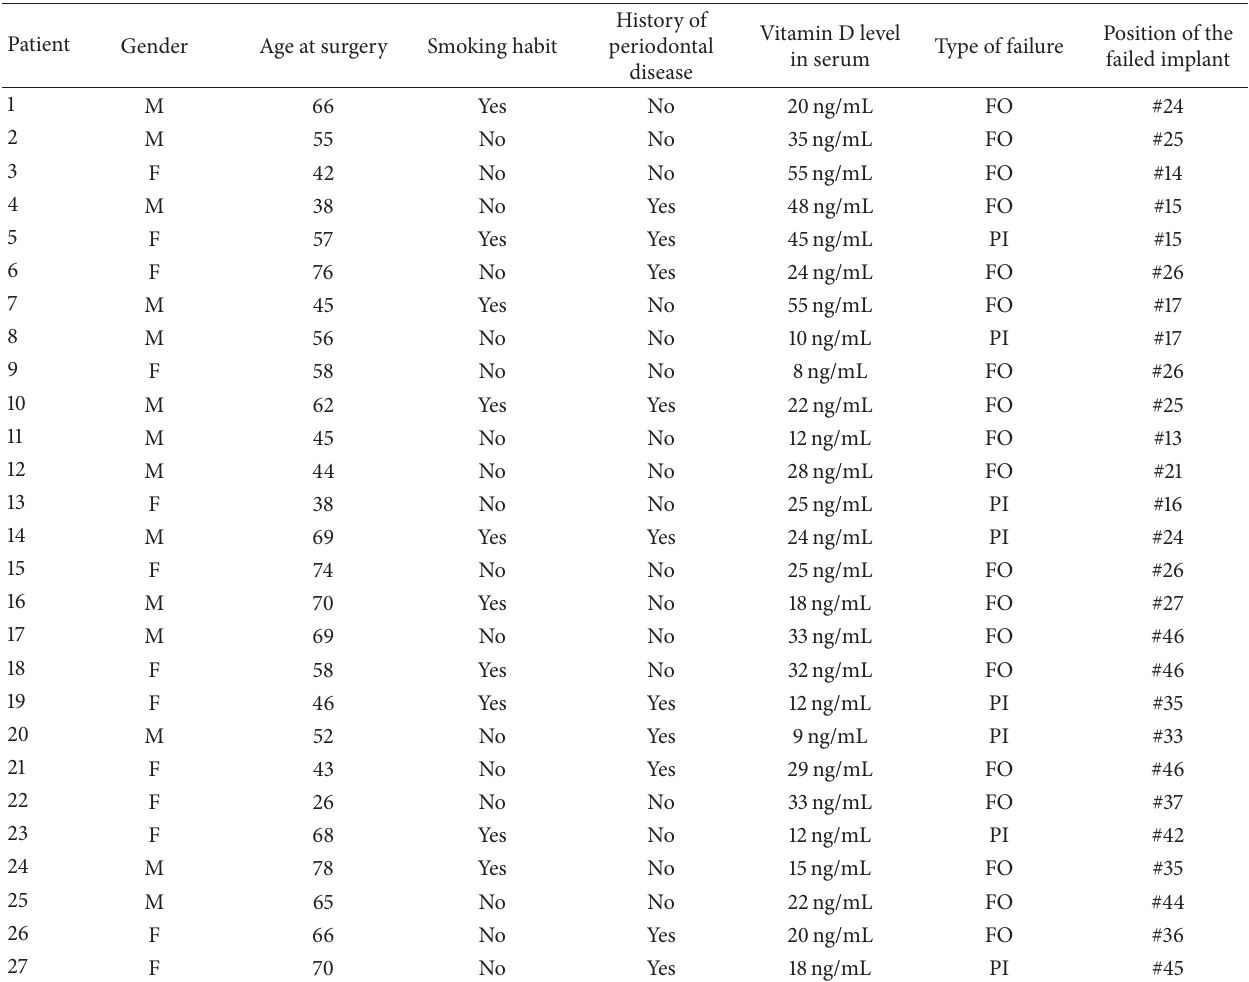
Table 2: Details of all early implant